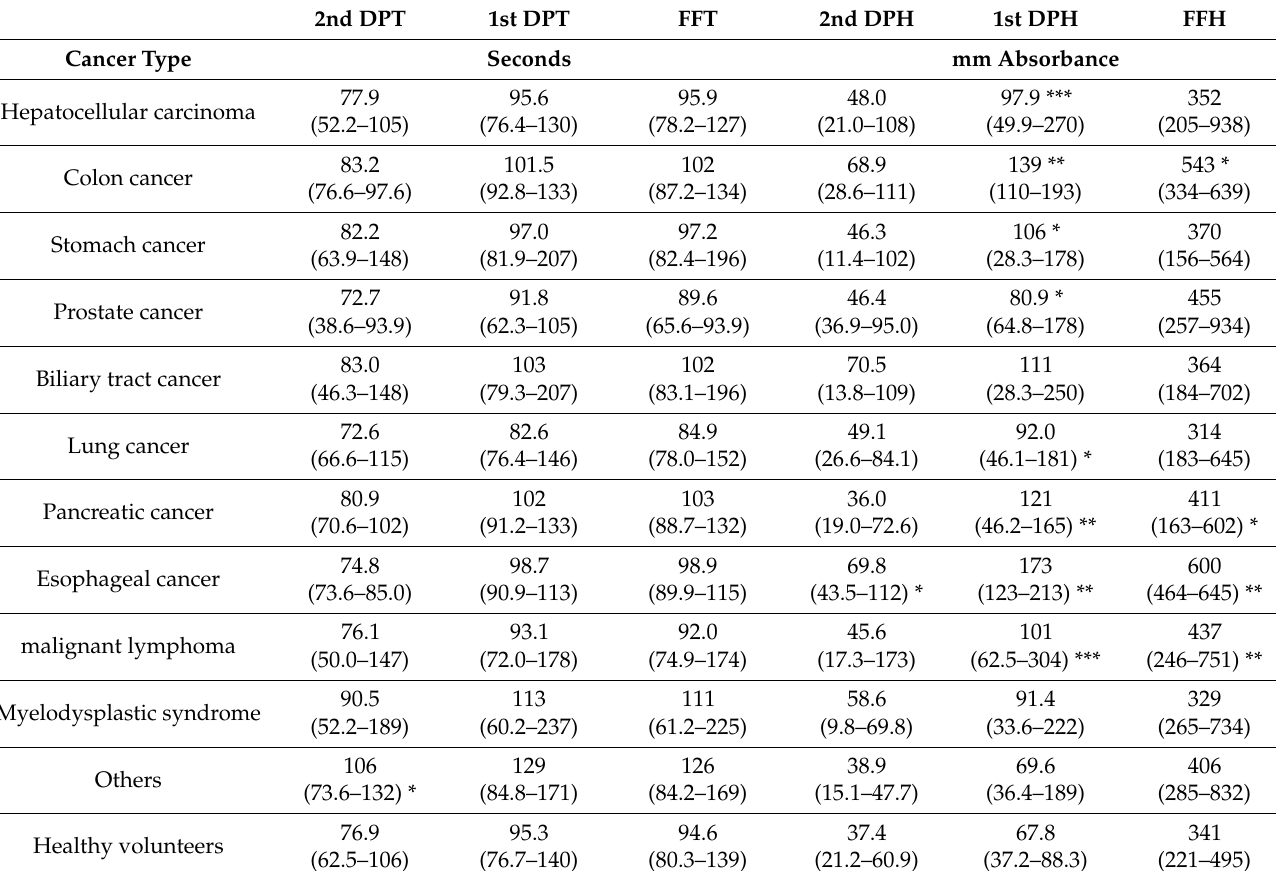
Table 3. CWA-sTF/FIXa in patients with malignant